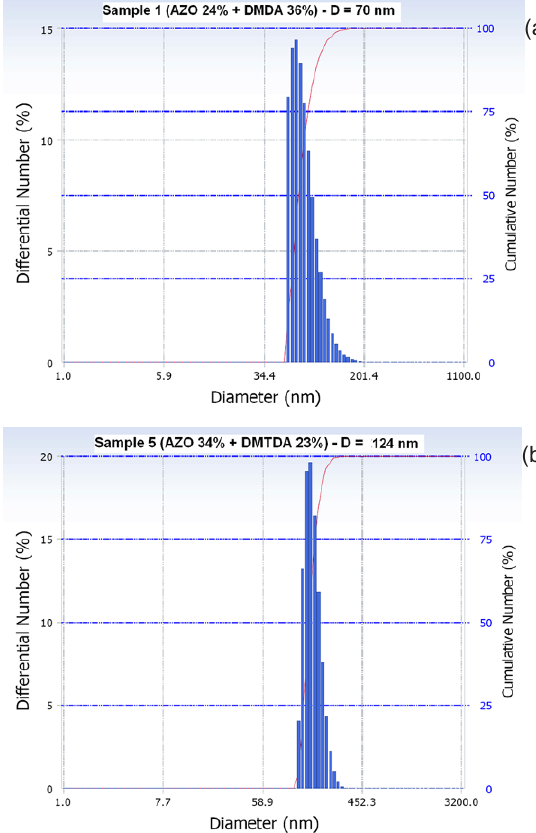
Figure 4. DLS analysis corresponding to Samples 1 (a) and 5 (b).